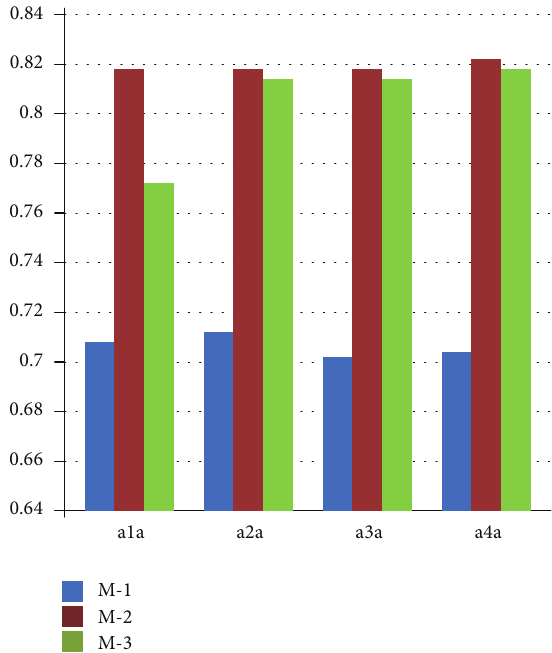
Figure 6: Comparison of the 𝐹 -measure among traditional C-SVM (M-1), number proportion-based optimization (M-2), and density- based optimization (M-3) via datasets in which the size of the negative instances was several times greater than that of the positive instances.